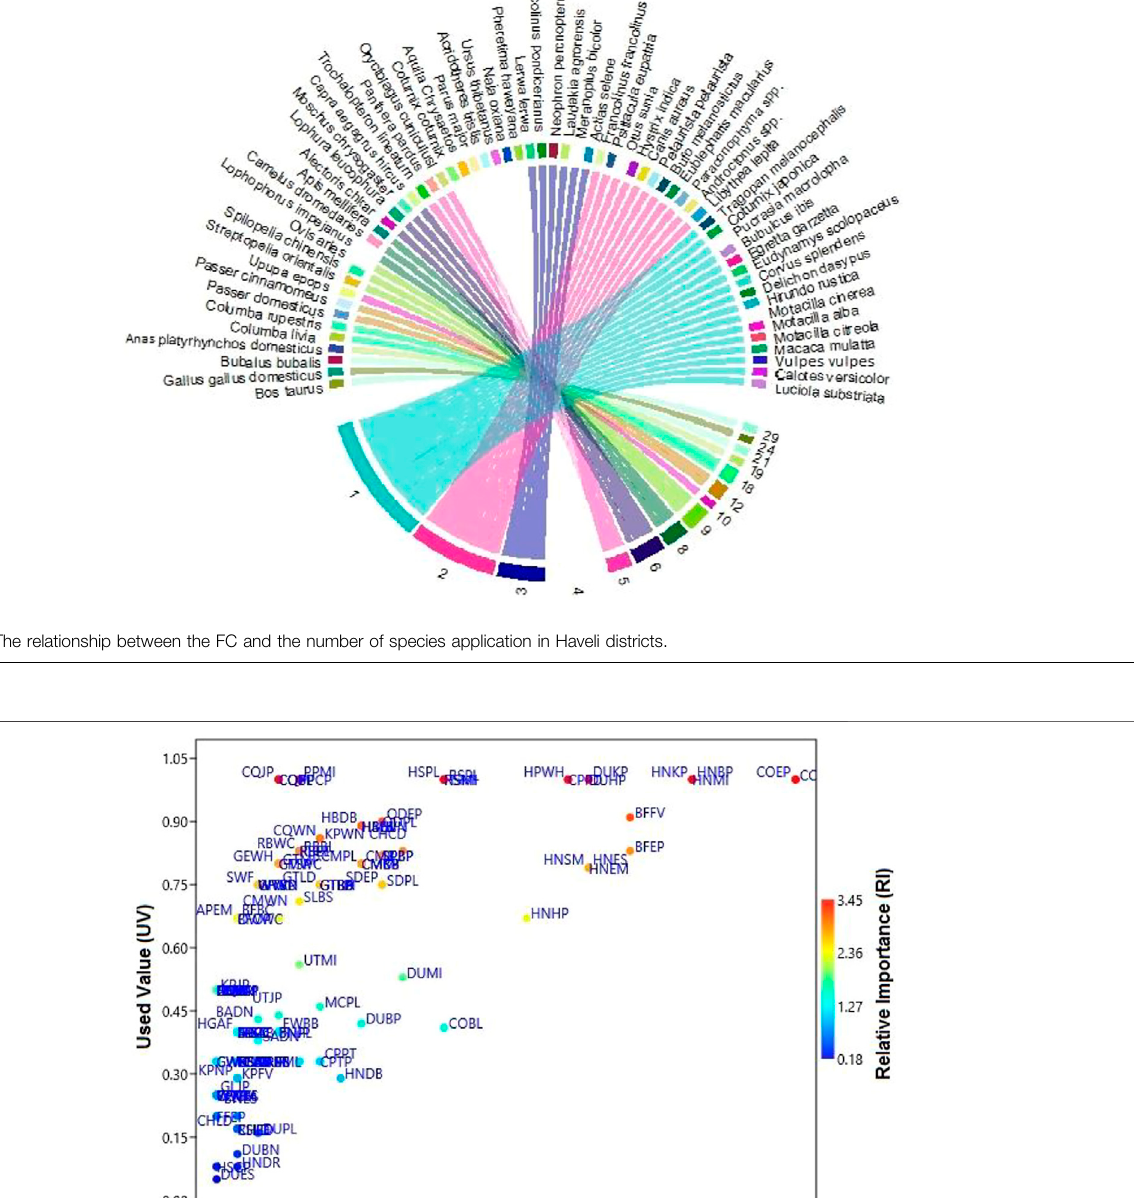
Frontiers in Pharmacology |